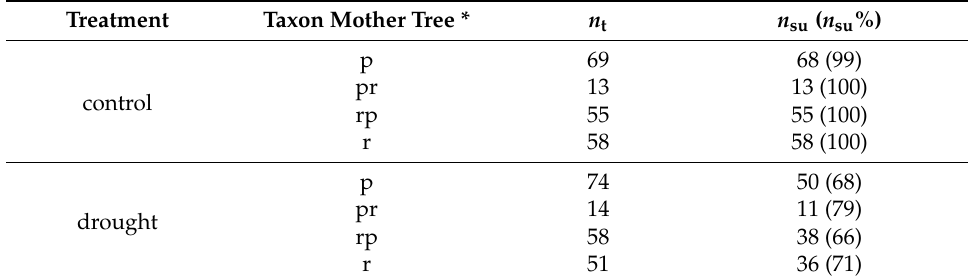
Table 1. Number of oak seedlings according to the treatment and the taxon of the mother tree ( n t ) and number of seedlings that survived the first growing season ( n su ), also expressed in % ( n su %). Treatment Taxon Mother Tree